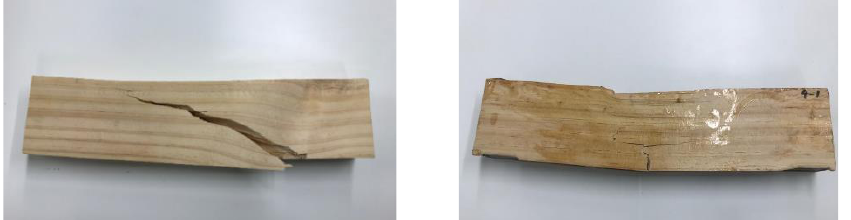
Figure 5. A 40 × 80 sample piece from benchmark case 1 ( left ) compared to the most promising reinforced 40 × 80 sample Case 4 ( right ) after loading.